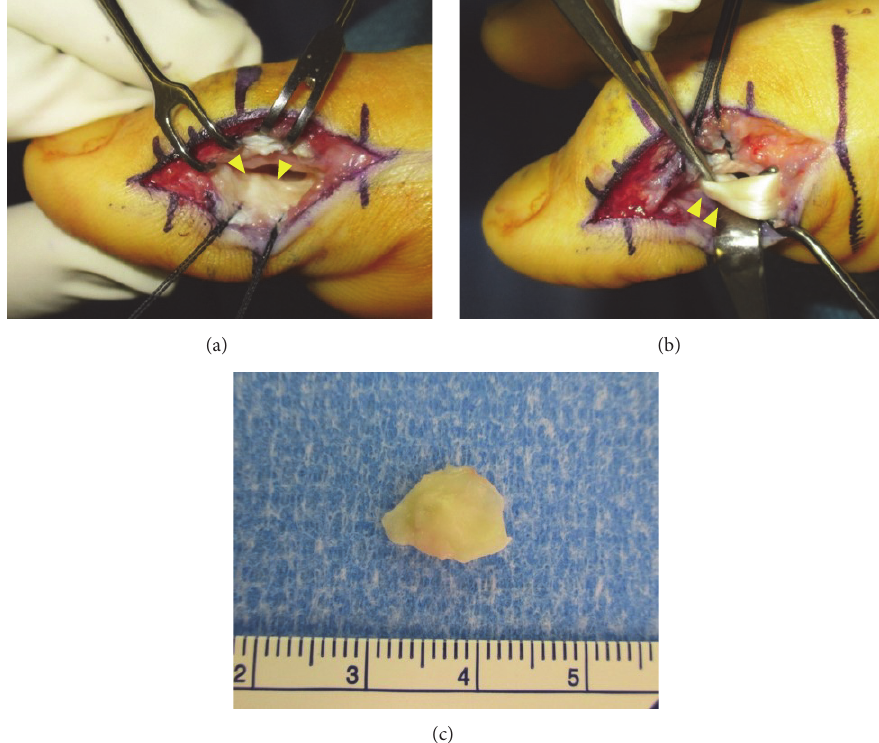
Figure 4: Surgical resection of the plantar capsular accessory ossicle at the interphalangeal joint (IPJ) via medial approach. (a) The IPJ plantar capsular ossicle (arrow heads). (b) The constricted flexor hallucis longus tendon at the level of the IPJ plantar capsular ossicle (arrow heads). (c) Removed IPJ plantar capsular accessory